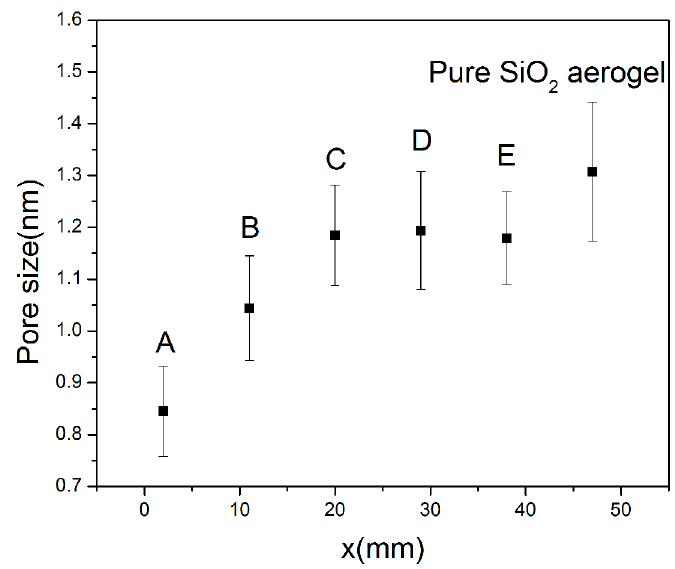
Figure 6. The average pore diameter of composite aerogels at five positions (A: x = 2 mm; B: x = 11 mm; C: x = 20 mm; D: x = 29 mm; E: x = 38 mm) and pure silica aerogel.